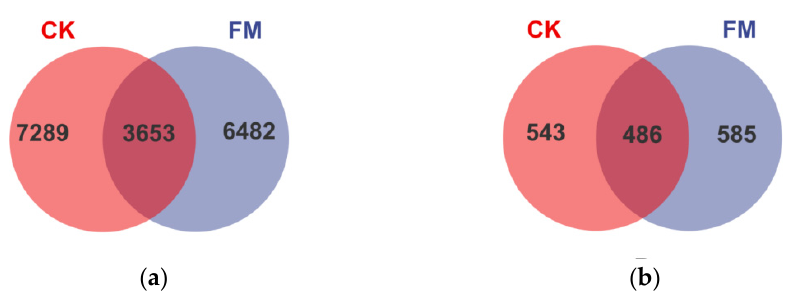
Figure 2. Venn diagrams of bacteria ( a ) and fungi ( b ) of OTUs in FM and CK samples. Table 2. Microbial diversity index. The different letters after the numbers represent the significance of the difference between the data.